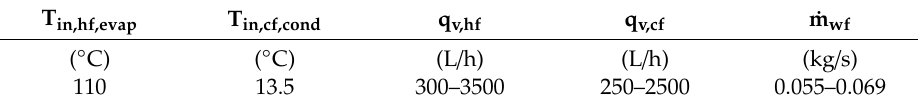
Table 3. Main parameter